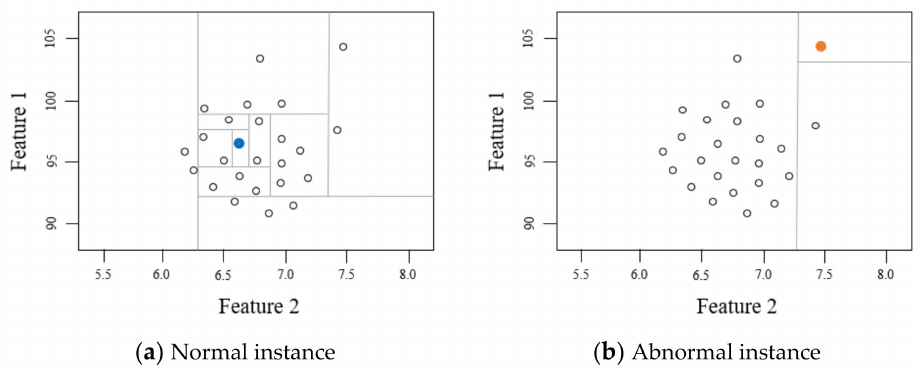
Figure 1. Diagnosis of normal and abnormal instance using isolation